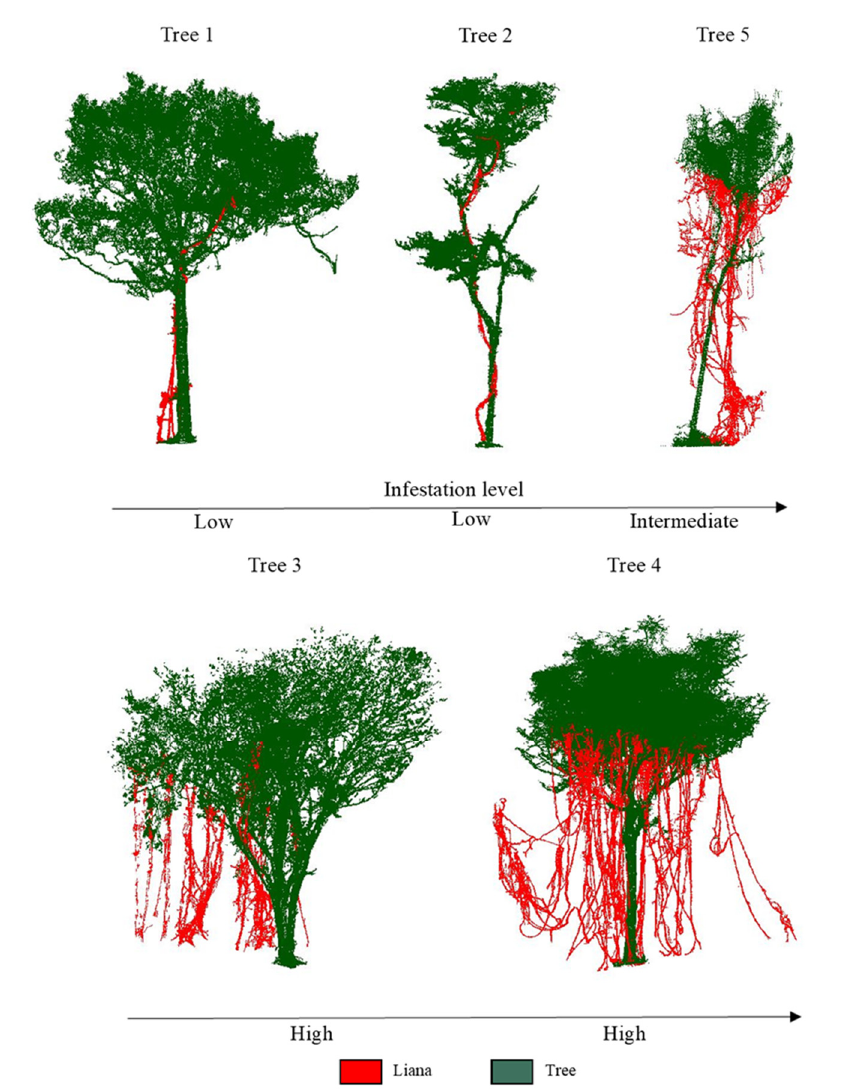
Figure 1. Trees with different liana infestations collected at the SRNP–EMSS, Guanacaste, Costa Rica; the red color indicates the lianas stem, while the green color is the tree.